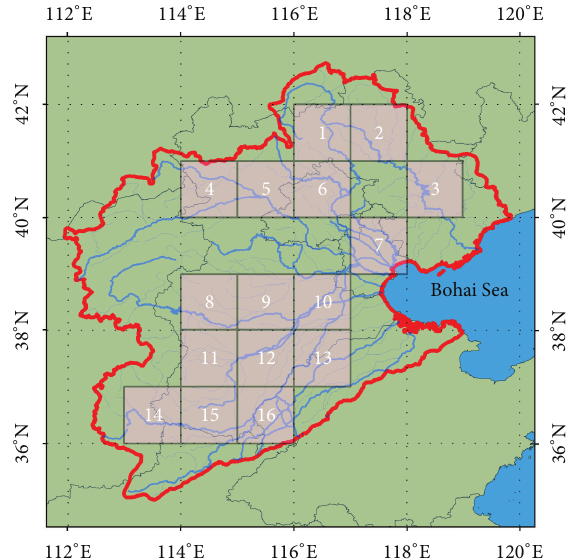
Figure 2: Location of 1 × 1 pixels for drought evaluation using the TWS from GRACE, the precipitation, and the vegetation